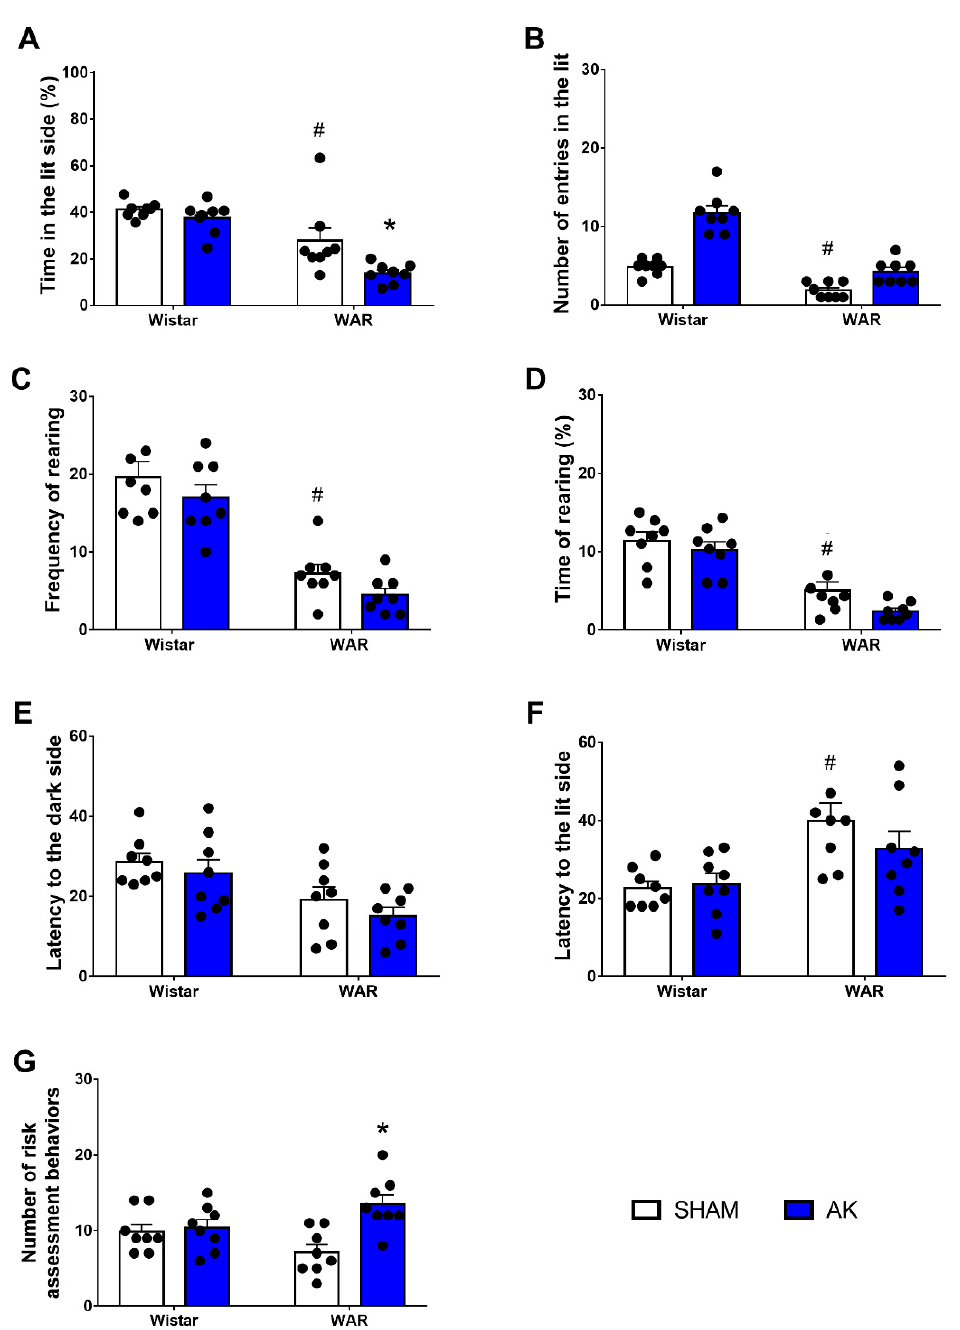
Figure 4. Assessment of anxiety-like behavior in the light/dark box (LDB) test. The measures ana- lyzed were ( A ) percentage of time in the lit side of the box, ( B ) the number of crossings, ( C ) frequency rearing, ( D ) time of rearing, ( E ) latency to the dark side, ( F ) latency to the lit side, and ( G ) risk assess- ment behaviors. The LBD test was performed during 5 min on the 11th experimental day. * p < 0.05 Tukey test comparing WAR-AK and WAR-Sham. # p < 0.05 Tukey test compared to WAR-Sham and Wistar-Sham. Data are expressed as mean ± standard error mean. N = 8/group. Two-Way ANOVA showed a significant strain effect in the number of entries in the lit side of the LDB, with WARs presenting a reduced number of entries in the lit side in compar- ison to Wistars (F1, 28 = 70.10; p < 0.0001). Again, the AK protocol showed no effects on the number of entries in the lit side, neither in WARs nor in Wistars (F1, 28 = 0.9333; p =